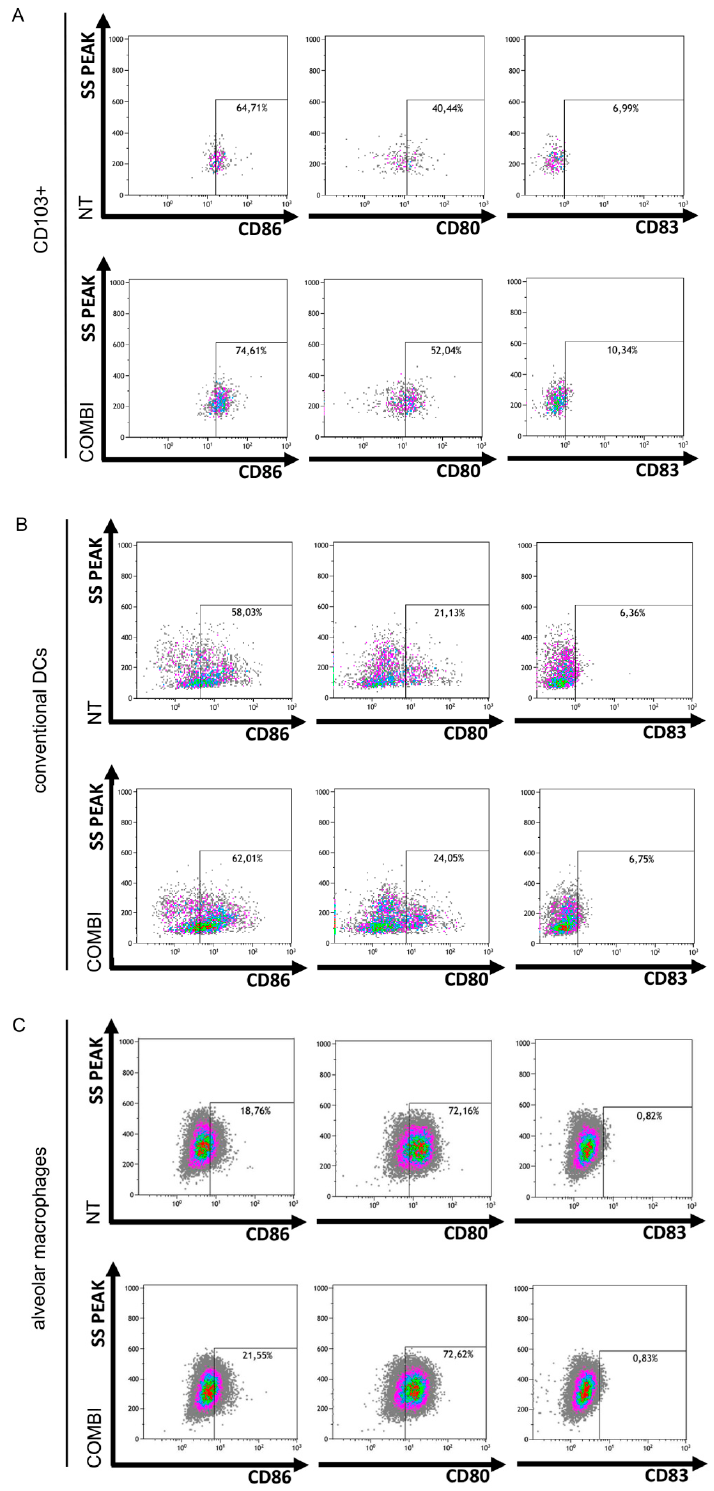
Figure 5. Lung cancer cell apoptosis mediated by TLR3 induces in vitro CD103 + lung DC activation. Murine lung immune cells were co-cultured with H460 cells that were untreated (NT) or pretreated with Poly(I:C) / INF α (COMBI), as in Figure S5. CD103 + DCs ( A ), conventional DCs (CD11b + DCs) ( B ) and alveolar macrophages (AMs) ( C ) were identified by cytofluorimetric analysis using the gating strategy reported in Figure S6. The percentage of CD86, CD80, and CD83 expression in CD103 + DCs (A), conventional DCs (B) and AMs (C) was determined and reported as dot plots in figure, comparing NT vs.